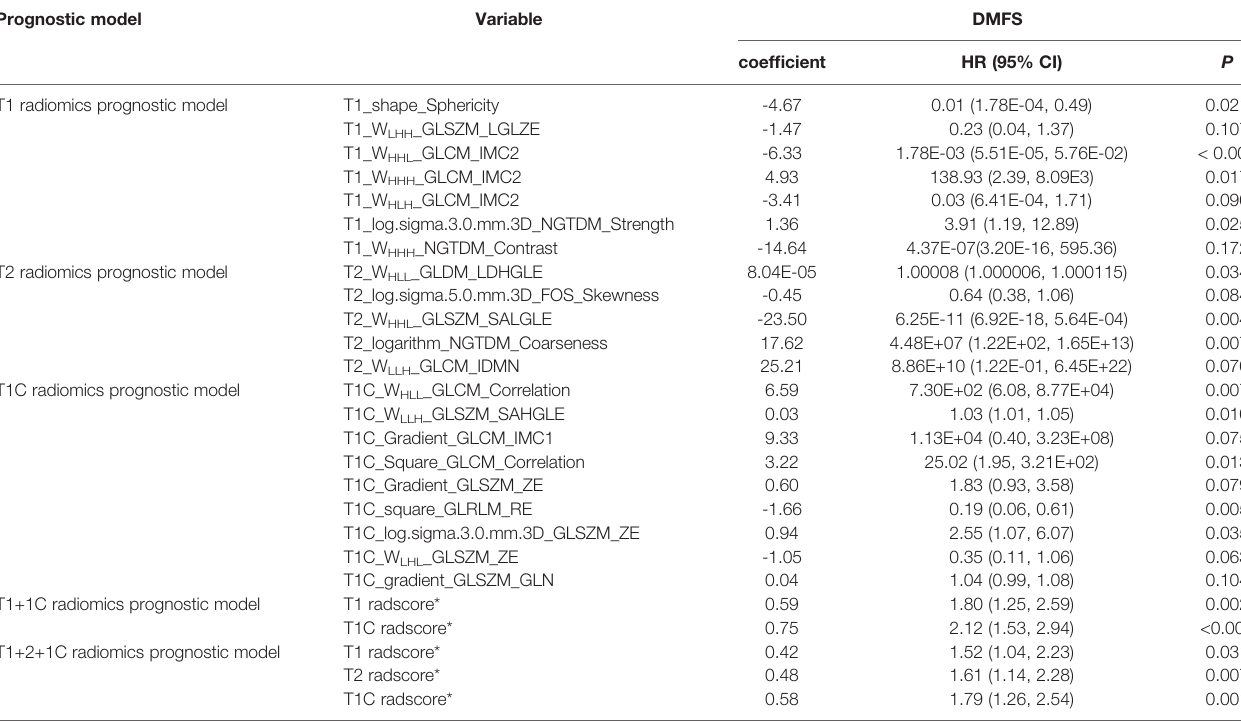
TABLE 3 | Multivariable analysis of radiomic features for the primary cohort. Prognostic model